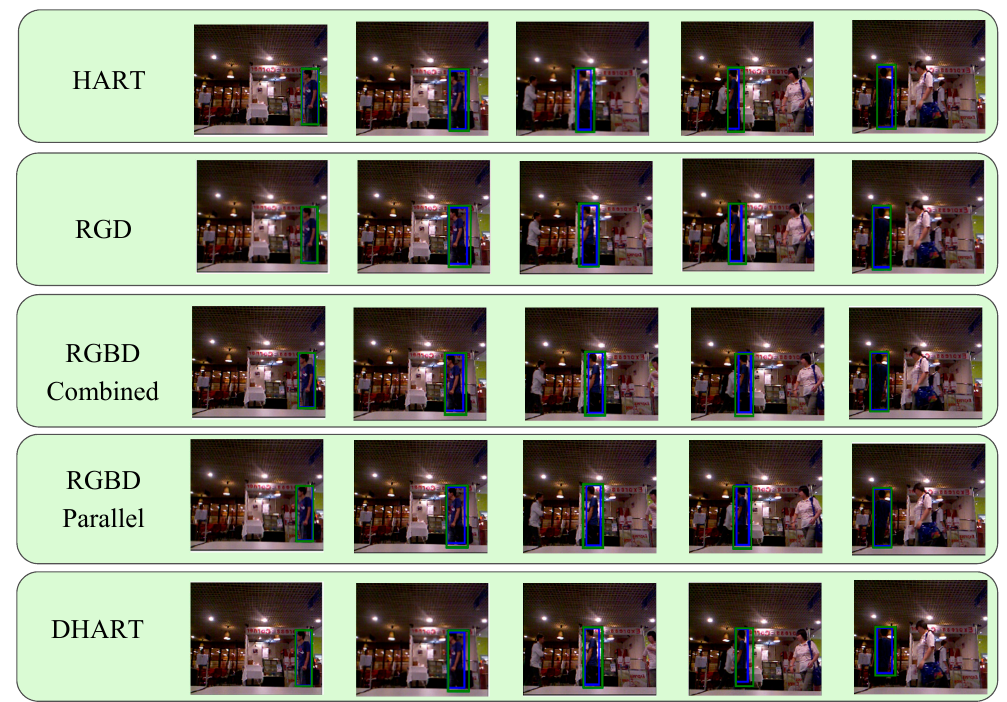
Figure 5. The object tracking model results with the Princeton dataset [4] (blue box—bounding box, green box—attention area): RGB, RGD, RGBD-combined, RGBD-parallel, and depth methods, from top to bottom, respectively. Each method successfully detected the target and tracked it. However, by using depth, the predicted bounding box was